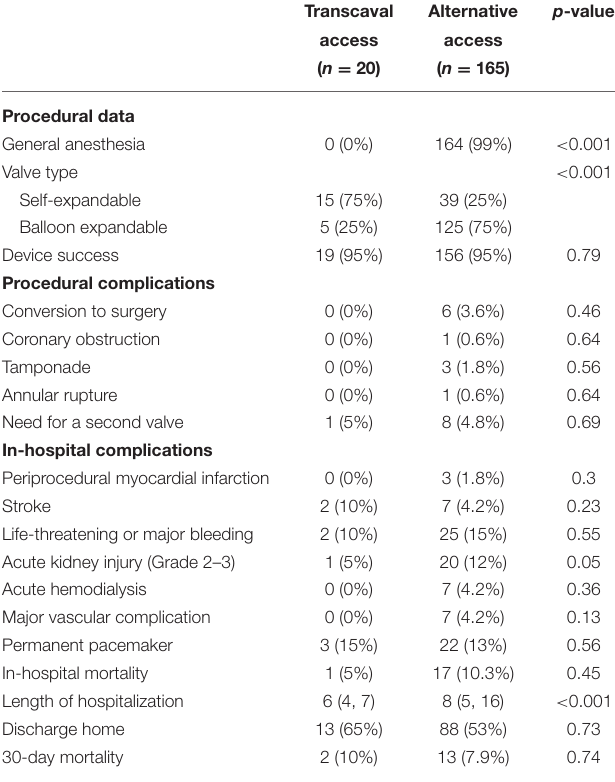
TABLE 2 | Procedural characteristics and outcome of patients undergoing TAVR via the transcaval vs. alternative